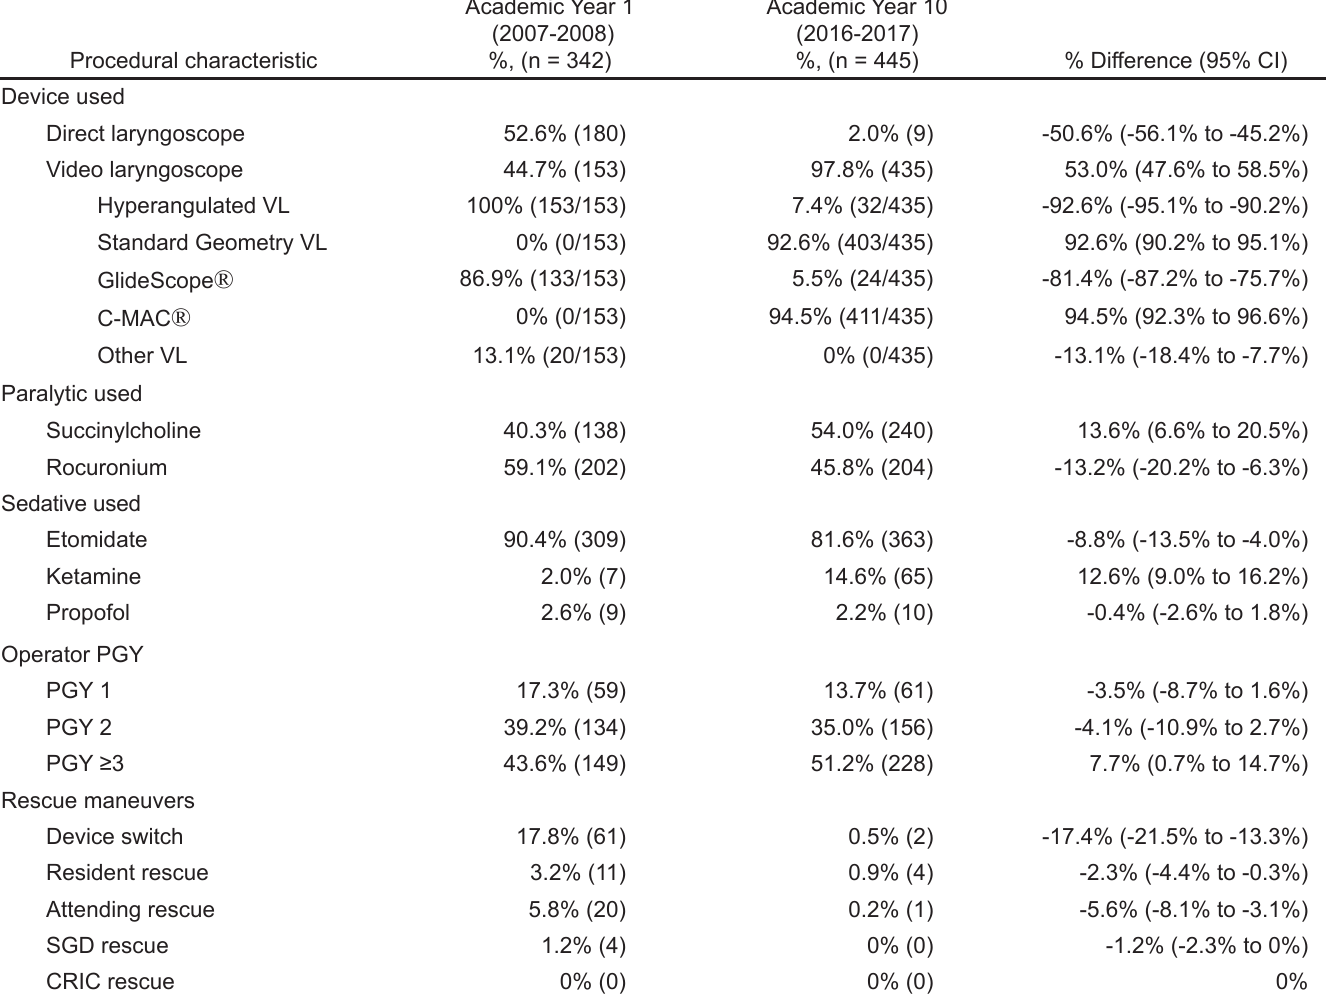
Table 5. Procedural characteristics in Academic Year 1 versus Academic Year